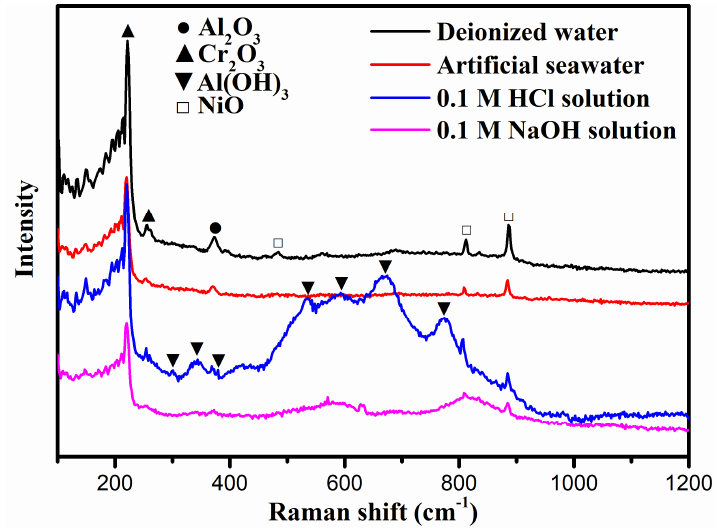
Figure 7. Raman spectra of worn surface of NiCrAlY coating in different corrosive solutions.